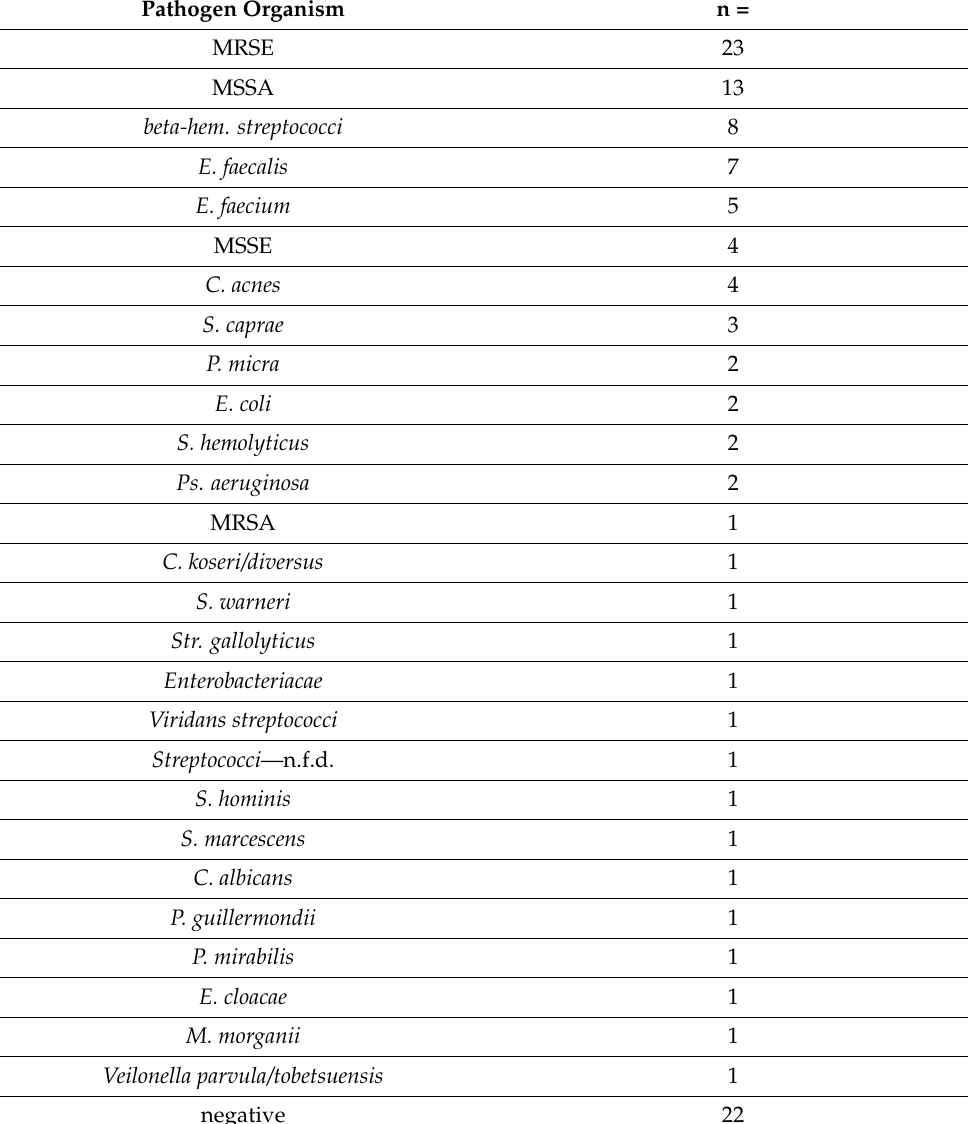
Table 2. Microbiological